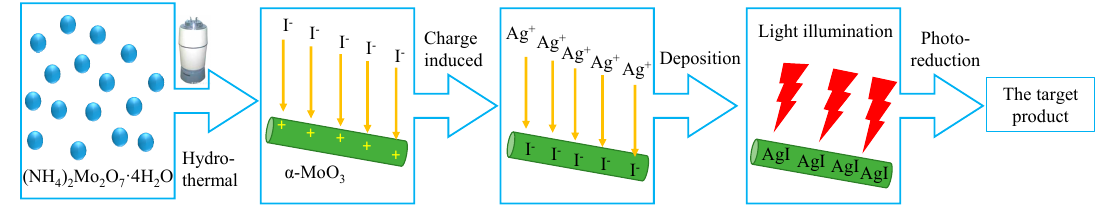
Scheme 1. Schematic illustration of the synthetic process of AAM heterojunctions.